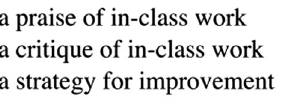
FIG. 3. The feedback structure described in the course materials is two similarly structured paragraphs focused on in-class work by the group and the